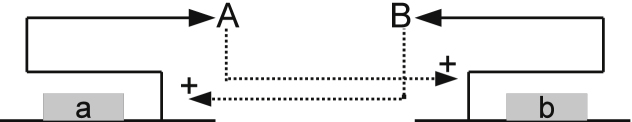
The two-gene regulatory network.